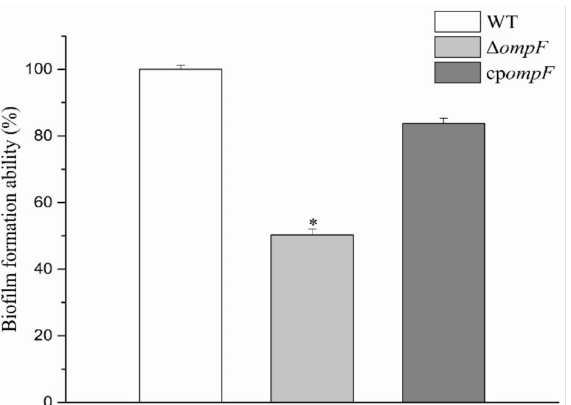
Figure 3. Comparison of the biofilm formation ability of different C. sakazakii isolates. The asterisks indicate that the percent biofilm formation by the mutant was significantly different ( p < 0.05) from that by the wild_type